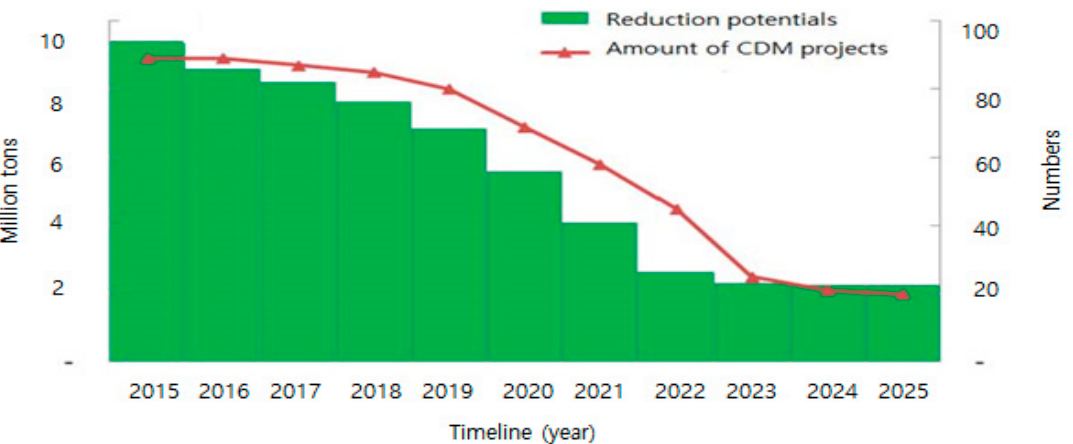
Figure 7. The prospects for the number of effective reduction projects and reduction potential of domestic Clean Development Mechanism (CDM) in Korea projects by year. Source: UNEP DTU CDM/JI Pipeline Analysis and Database; Available online: http://www.cdmpipeline.org/ (accessed on 14 June 2017)).